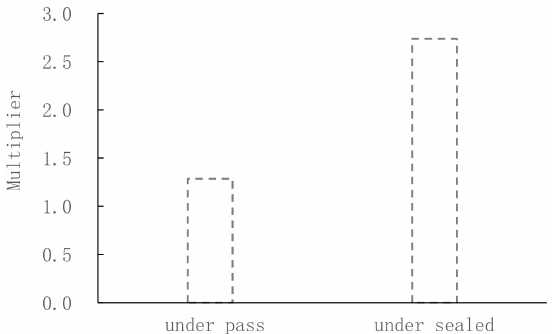
Figure 6. Comparison of coefficient of condensation.